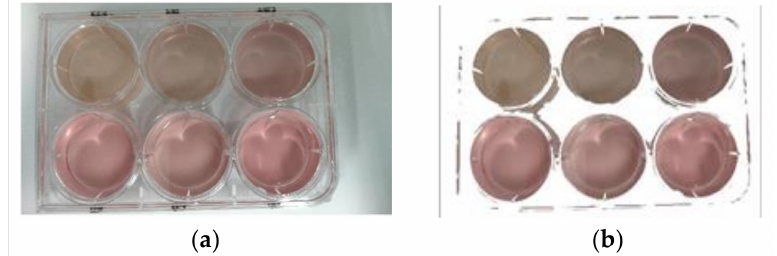
Figure 3. ( a ) Input image; ( b ) extracted red components of the image.